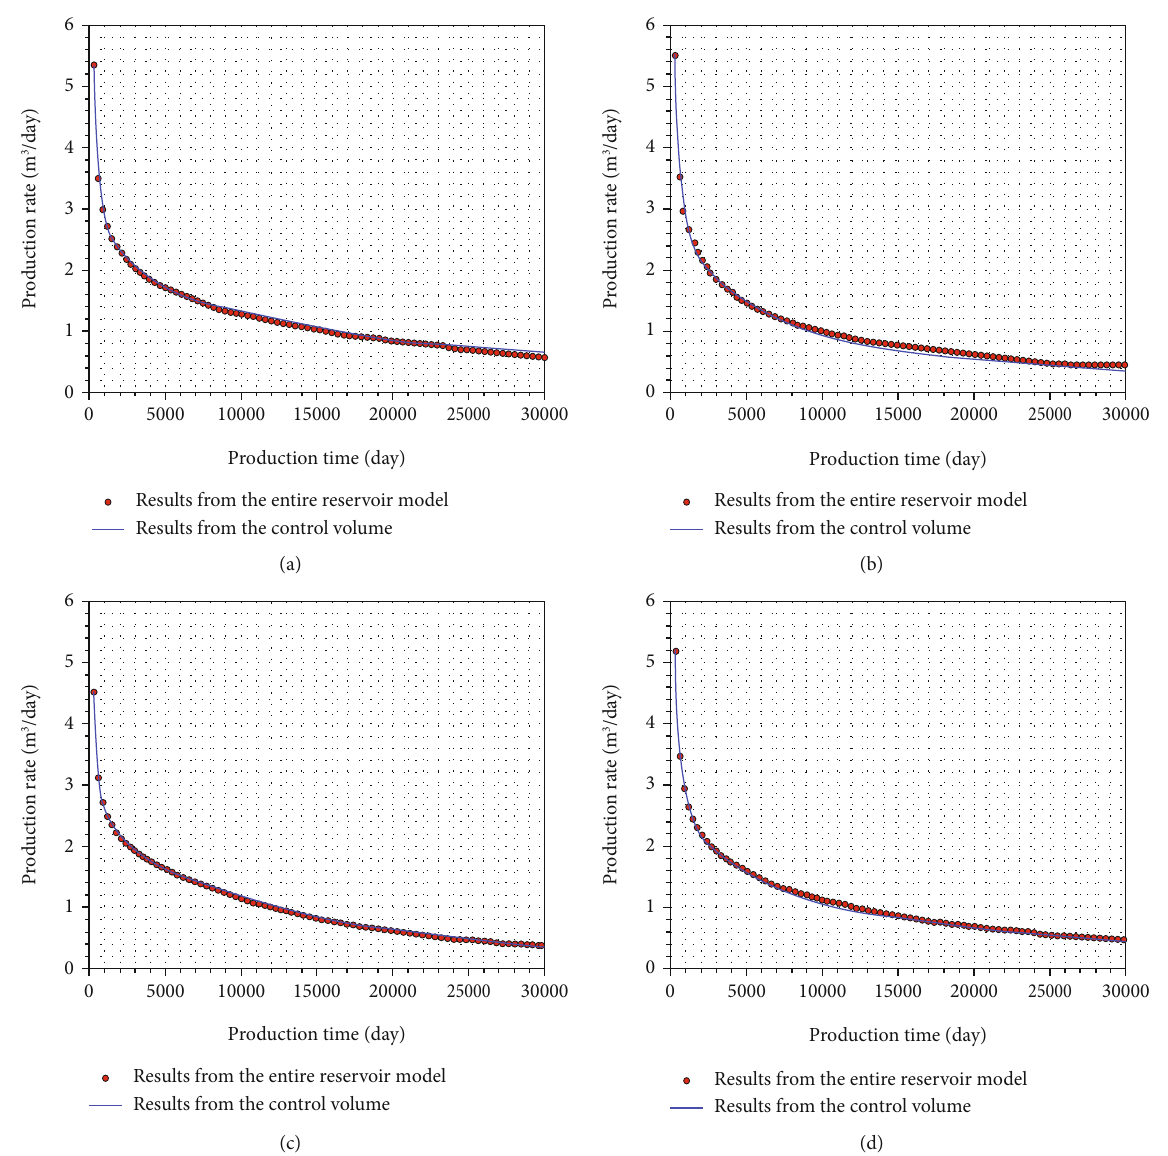
Figure 10: Comparison between the well performance that is predicted with the control volume to that with the entire reservoir model #2: (a) results of well #1, (b) results of well #2, (c) results of well #3, and (d) results of well